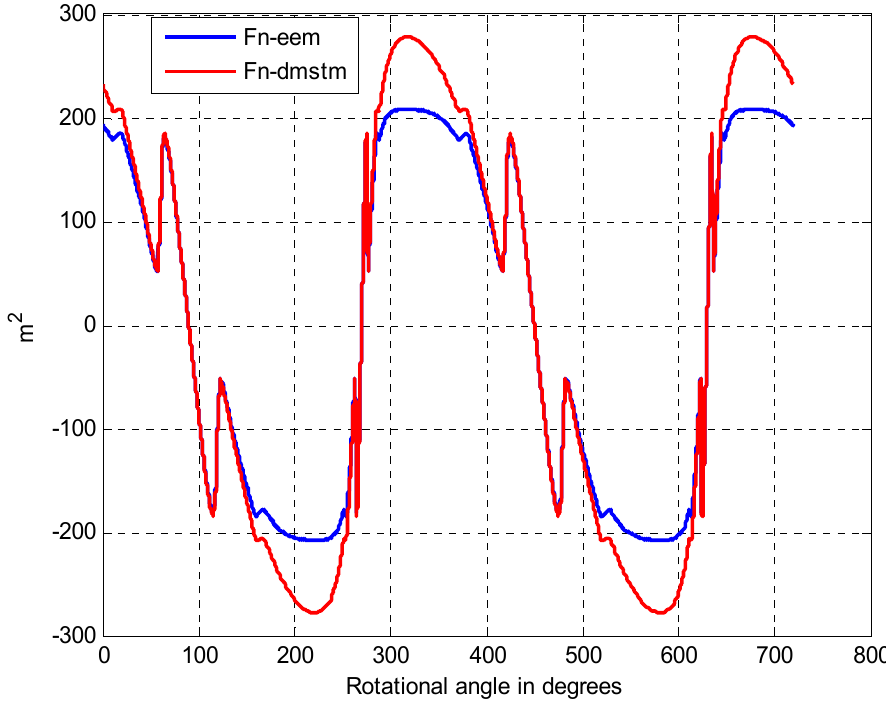
Figure 22. Cross validation of normal force variations as functions of rotational angle.